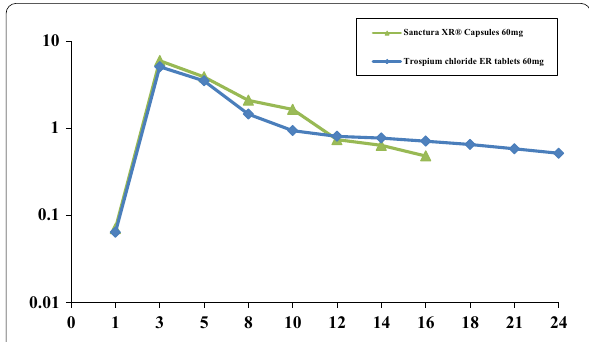
Fig. 9 Comparative mean plasma concentration of trospium chloride osmotic tablets and Sanctura XR ® capsule 60